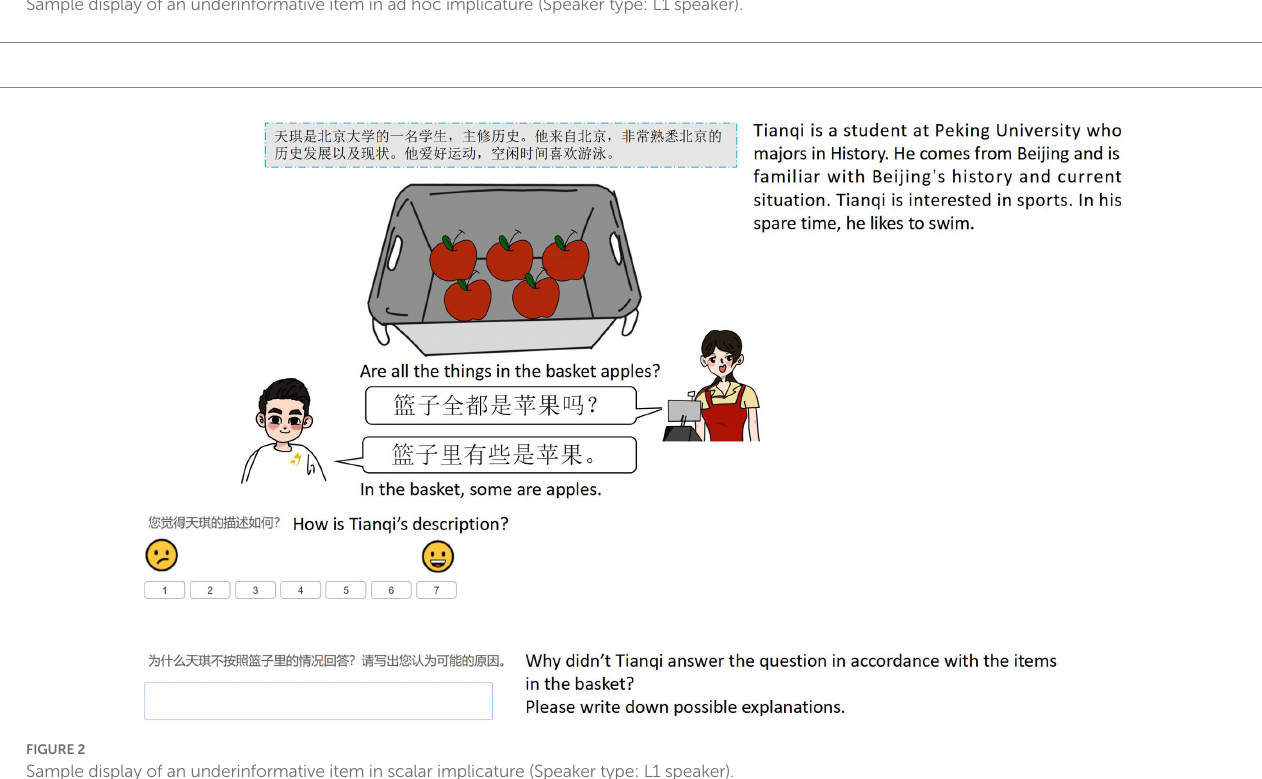
FIGURE 1 Sample display of an underinformative item in ad hoc implicature (Speaker type: L1 speaker).